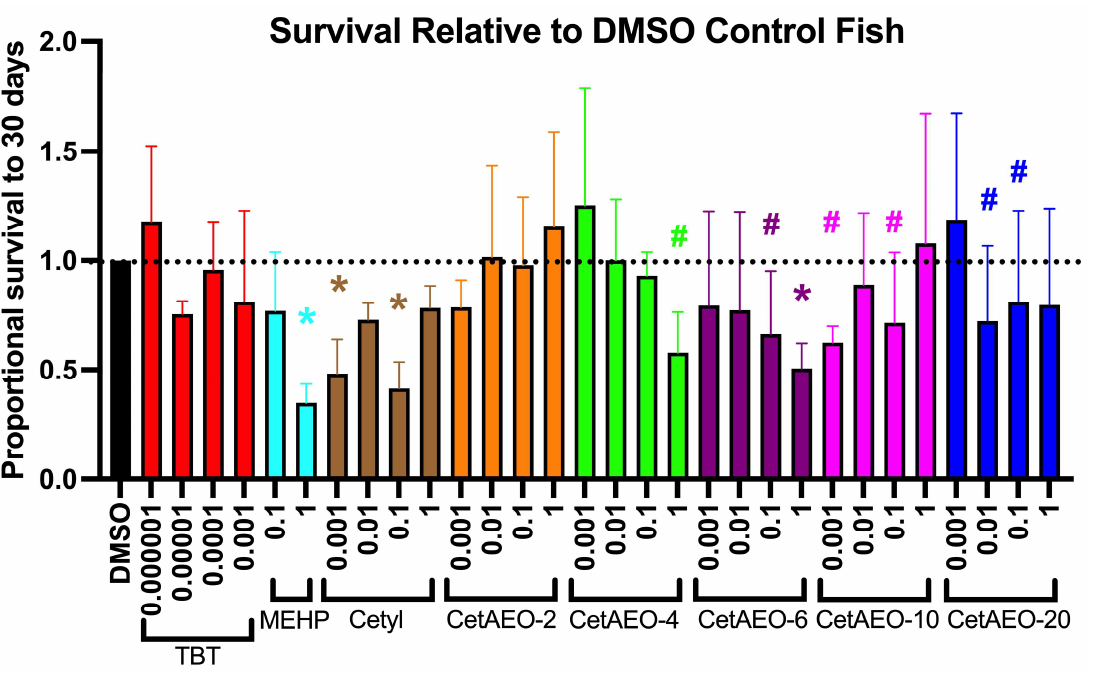
Figure 2. Lethality of Cetyl Alcohol and Polyethoxylates in Developmentally Exposed Zebrafish. Zebrafish were developmentally exposed to control chemicals, cetyl alcohol, or cetyl alcohol polyethoxylates from one through six days post fertilization. Following exposures, fish were aged to 30 days post fertilization. Lethality was measured daily to determine survivorship across test chemicals and treatments for each test chemical (A). N = 15 replicate fish in each biological replicate (spawning event) for each test chemical and concentration, and four spawns were performed (four biological replicates) and averaged for responses depicted here for approximately 60 fish evaluated per experimental group. Lethality is depicted as survival percent relative to DMSO vehicle control exposed fish at 30 days. All concentrations are provided in μM. * indicates significant change in survival compared to vehicle control fish, p < 0.05, as per Kruskal–Wallis test with Dunn’s multiple comparisons. # indicates 0.05 < p < 0.10. DMSO = dimethylsulfoxide, vehicle control; TBT = tributyltin chloride; MEHP = Mono(2−ethylhexyl) phthalate; CetAEO = cetyl alcohol polyethoxylates (with varying average ethoxylate chain lengths).